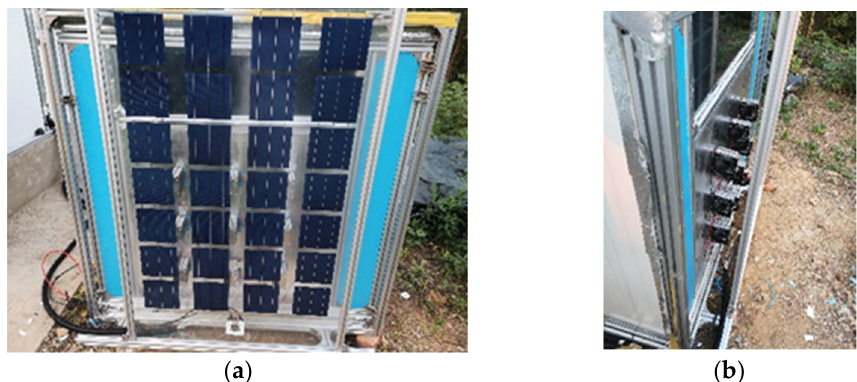
Figure 3. Experimental platform of PV-TEC radiant windows. ( a ) Front side. ( b ) Lateral side.